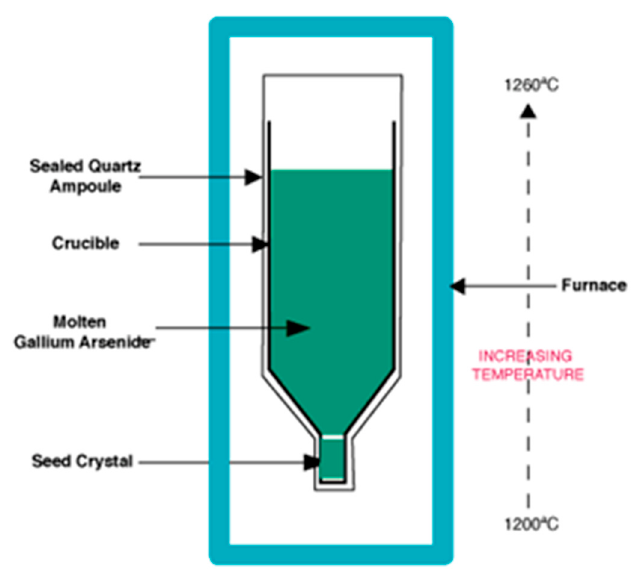
Figure 2. An example (GaAs crystal growth) of the experimental setup for the vertical gradient freeze method, adapted from [23].